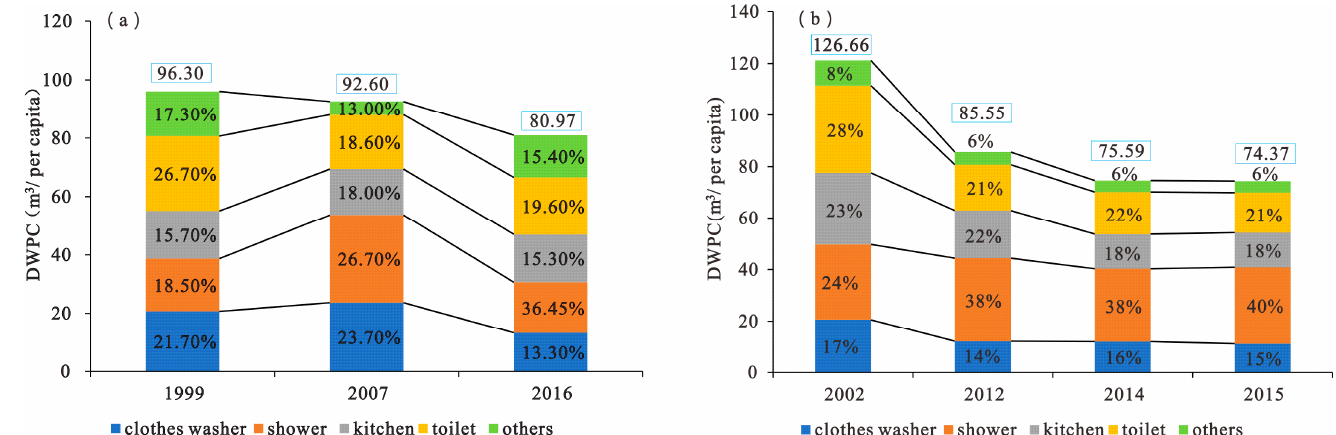
Figure 8. DWPC subsector proportions in ( a ) the US and ( b ) Japan.